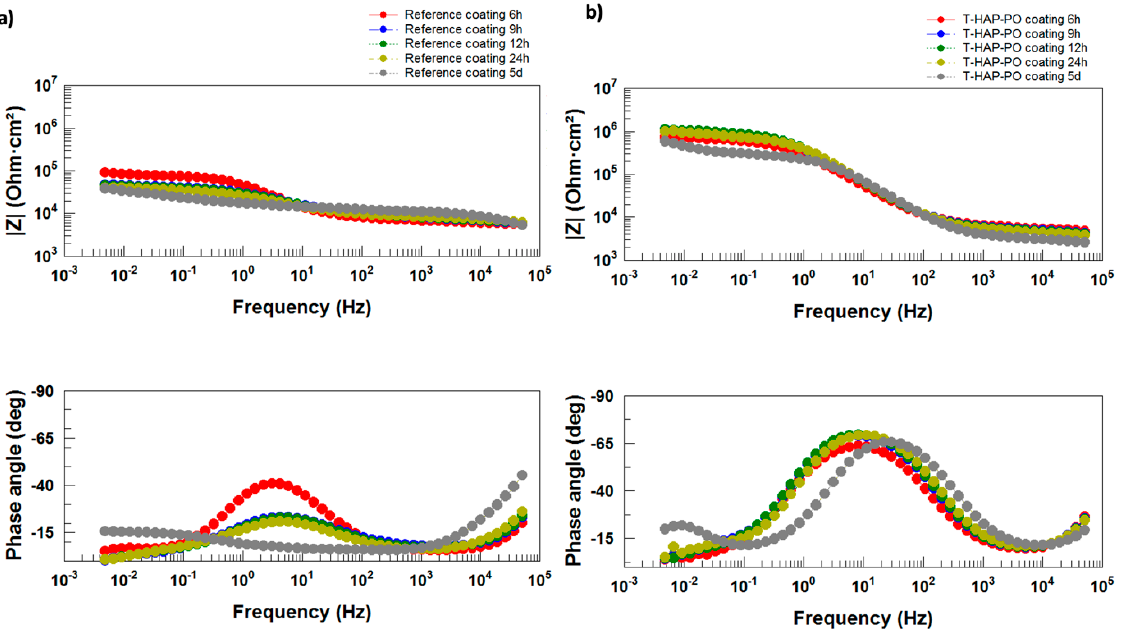
Figure 5. EIS Bode plots for the ( a ) reference coating and ( b ) coating modified with HAP particles loaded with tannic acid during immersion in 0.05 M NaCl with an artificial defect.